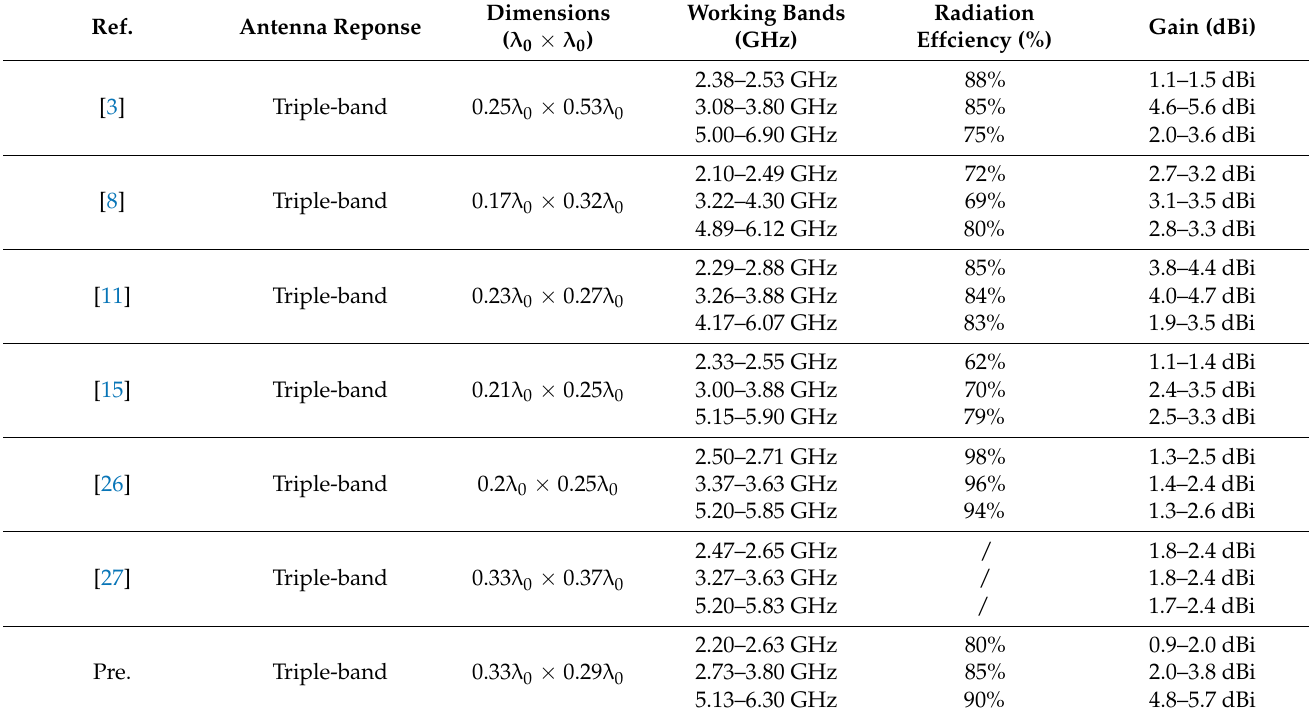
Table 1. Comparison of proposed NTTPA with previous